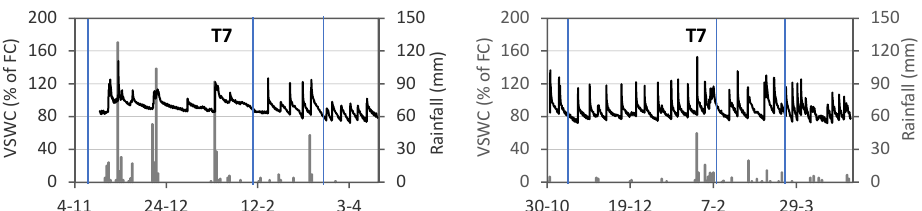
Figure 2. Volumetric soil water content (VSWC in percentage of field capacity (FC) − 15 cm, − 25 cm) for each irrigation strategy and daily rainfall during the two growing seasons. Crop growth stages: (1) initial; (2) vegetative growth; (3) bulbing; and (4) bulb ripening.